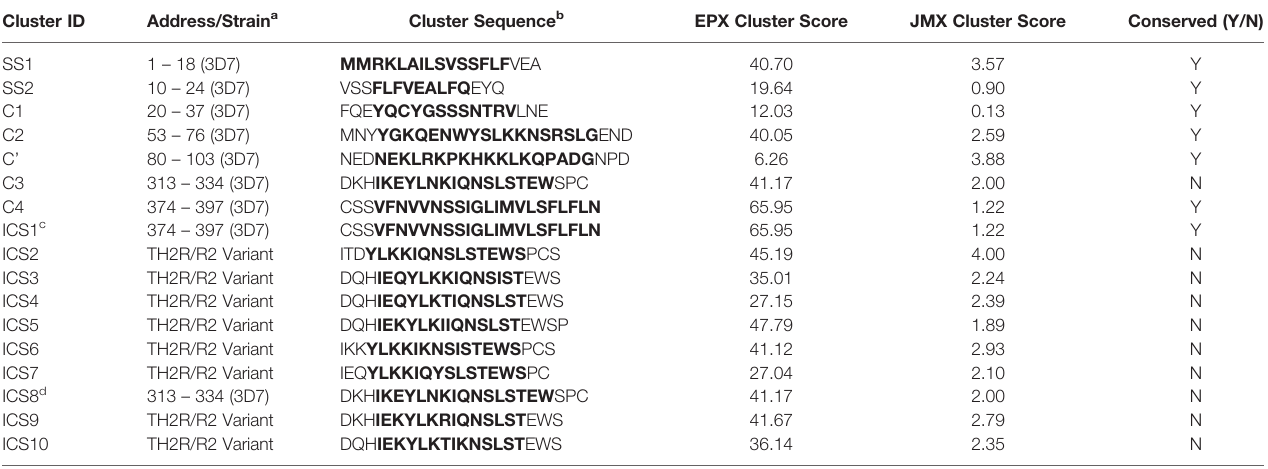
TABLE 1 | Clusters of Predicted Class II Epitopes within PfCSP Associated with EpiMatrix (EPX) and JanusMatrix (JMX) Cluster Scores.